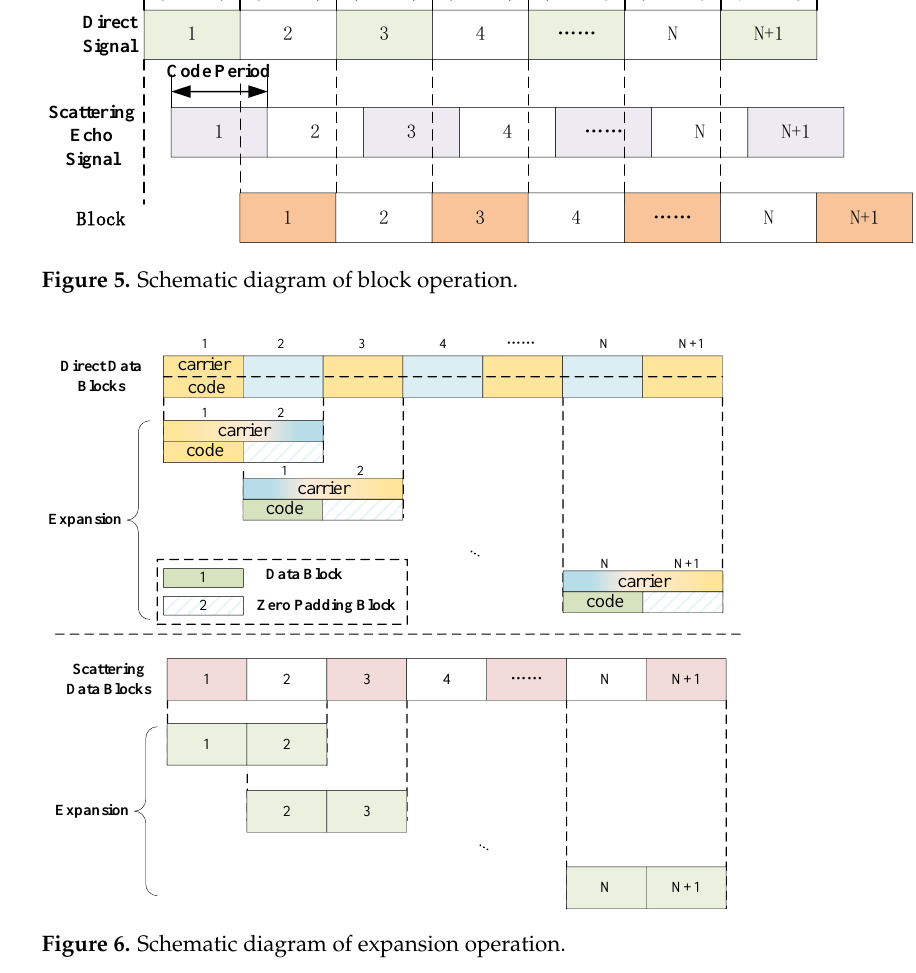
Figure 7. Schematic diagram of data compress.